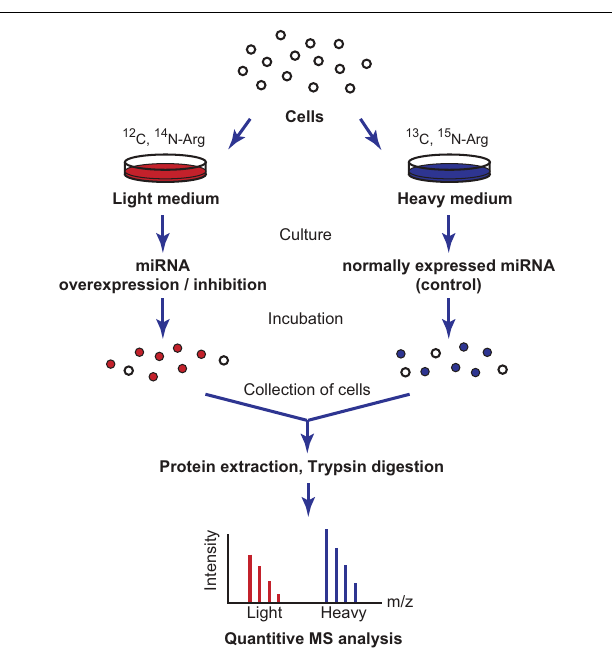
FIGURE 2 | Schematic representation of SILAC labeling and proteome analysis. Cells are split and cultured in heavy or light medium containing different amino acid isotopes.The miRNAs are then overexpressed or inhibited within these cells, and the cells are incubated for several more hours.The cells are collected and their proteins are purified for further mass spectrometric analysis.The protein levels in the two samples are compared by quantifying the heavy and light peptides, because isotopic labeling will affect their migration